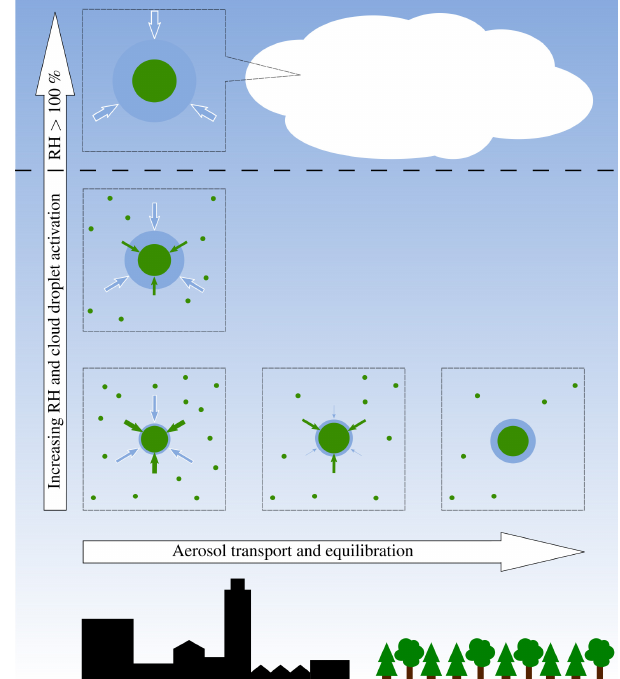
Figure 1. Schematic of the two different condensation processes occurring in the atmosphere with condensation rates of organics and water indicated by the size of the green and blue arrows, re- spectively. The lower three inset boxes show the equilibration be- tween the vapour and condensed phases of the semi-volatile organic compounds during large-scale aerosol transport. Gas-phase species change due to the air mass passing over anthropogenic and biogenic emission sources, as well as oxidation and gas-phase reactions. The left three boxes show the rapid depletion of the vapour phase of or- ganics that results from the relative humidity reaching and exceed- ing 100%. Ground-based emissions sources of SVOCs do not con- tribute additional vapour mass to the rising air parcel represented by the left three inset